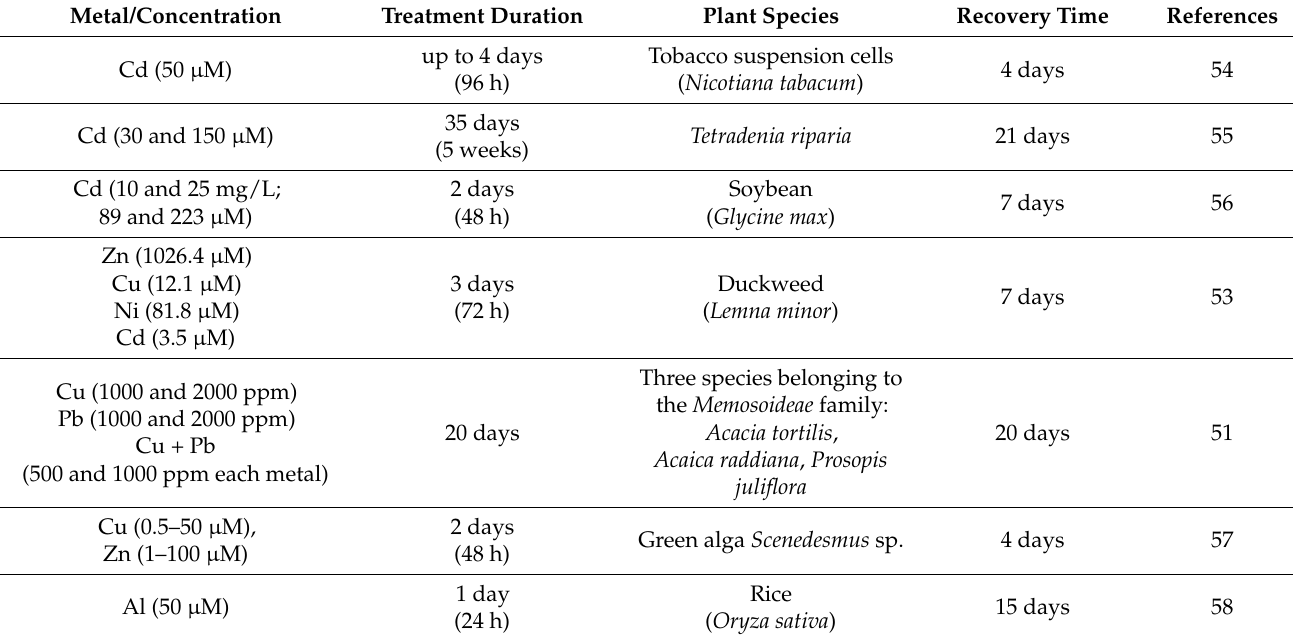
Table 1. The list of studies on plants recovery from metal stress with indicated plant species, applied metal and duration of the treatment and recovery